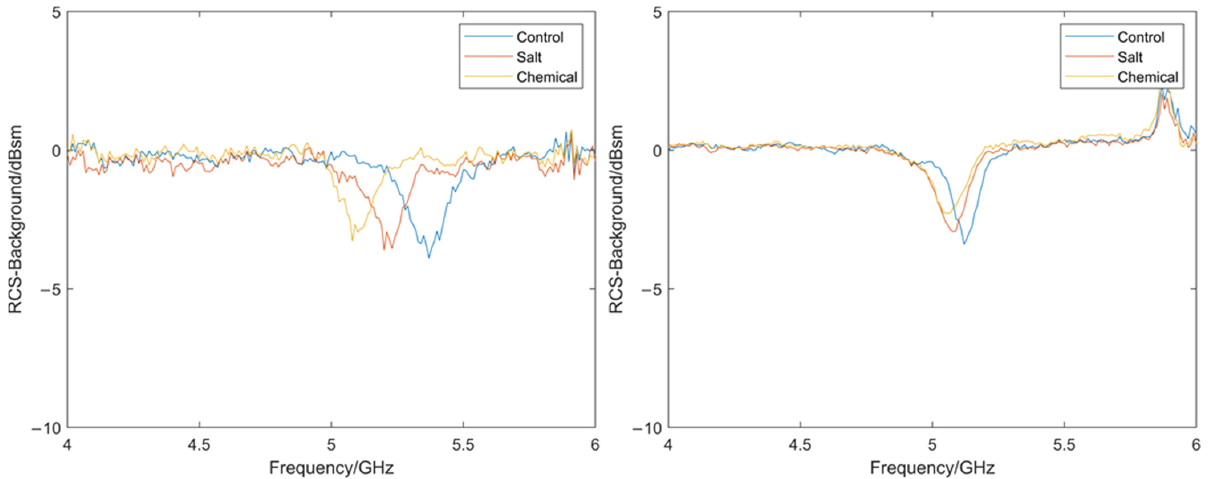
Figure 19. Measured RCS for a PVC coating system ( left ) and a PU coating system ( right ) samples exposed to salt and chemical degradation. exposed to salt and chemical degradation.